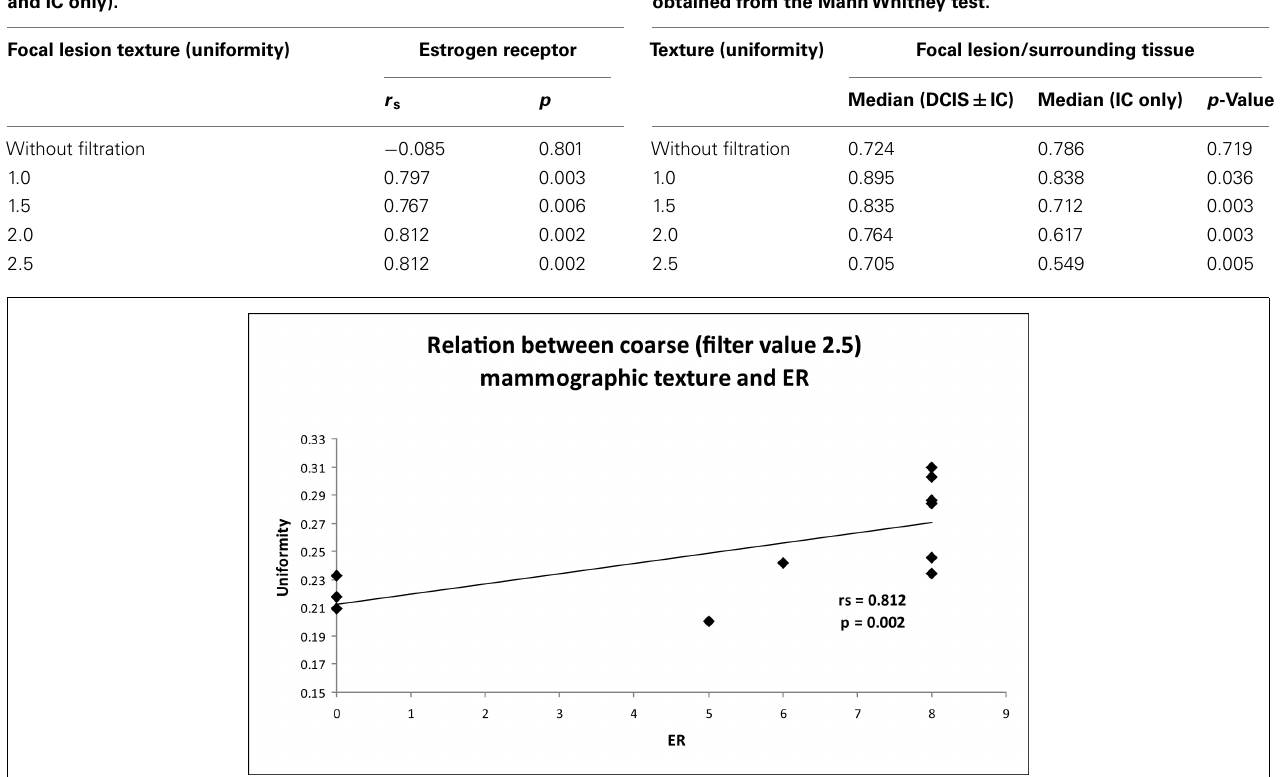
Table 3 | Spearman rank correlation coefficients ( r s ) and p -values indicate the relationship between estrogen receptor status and focal lesion texture (uniformity) in all the patients (DCIS only, IC with DCIS and IC only).